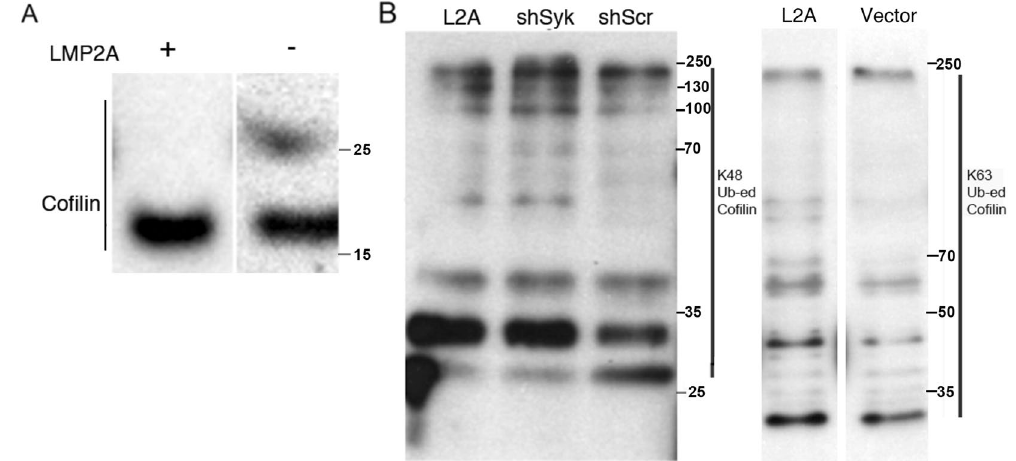
Figure 2. LMP2A expression interferes with ubiquitin modification of cofilin and with ubiquitin-branching patterns in cofilin immunoprecipitates. CNE2 NPC cells were treated with the MG132 proteasome inhibitor prior to lysis to prevent degradation of ubiquitinated proteins. ( A ) Whole cell lysates (wcl) of CNE2 cells were immunoblotted with cofilin antibody. Ubiquitin modifications of the proteins in the cofilin immunoprecipitates were probed with either K48-ubiquitin specific antibody ( B ) or K63-ubiquitin specific antibody ( C ). Full-length blots are presented in Supplementary Figure